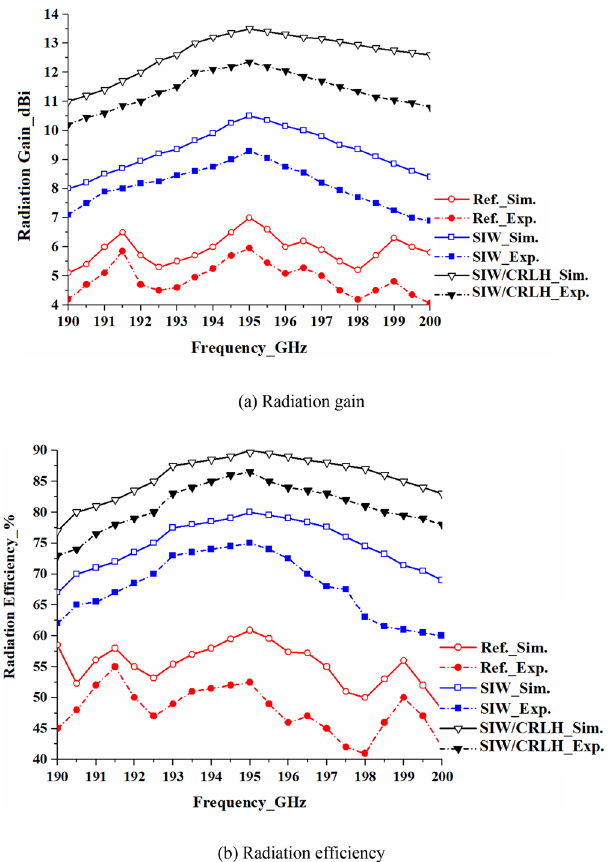
Figure 15. Simulated and experimental results of the radiation gain and efficiency as a function of frequency of the reference, SIW-loaded, and SIW-loaded MTM (CRLH) antenna arrays.